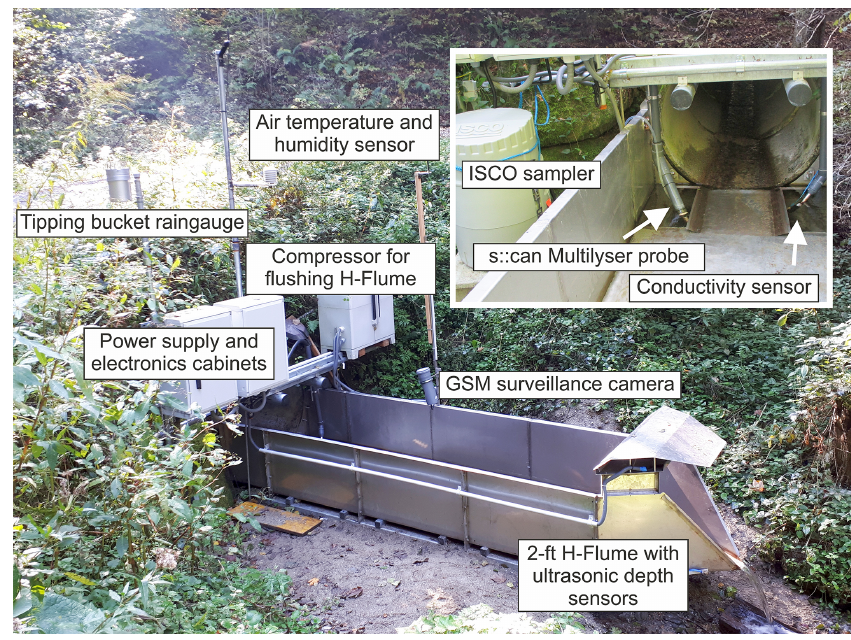
Figure 4. Gauging site Q4 with 2-ft H-flume, spectrometer device and ISCO